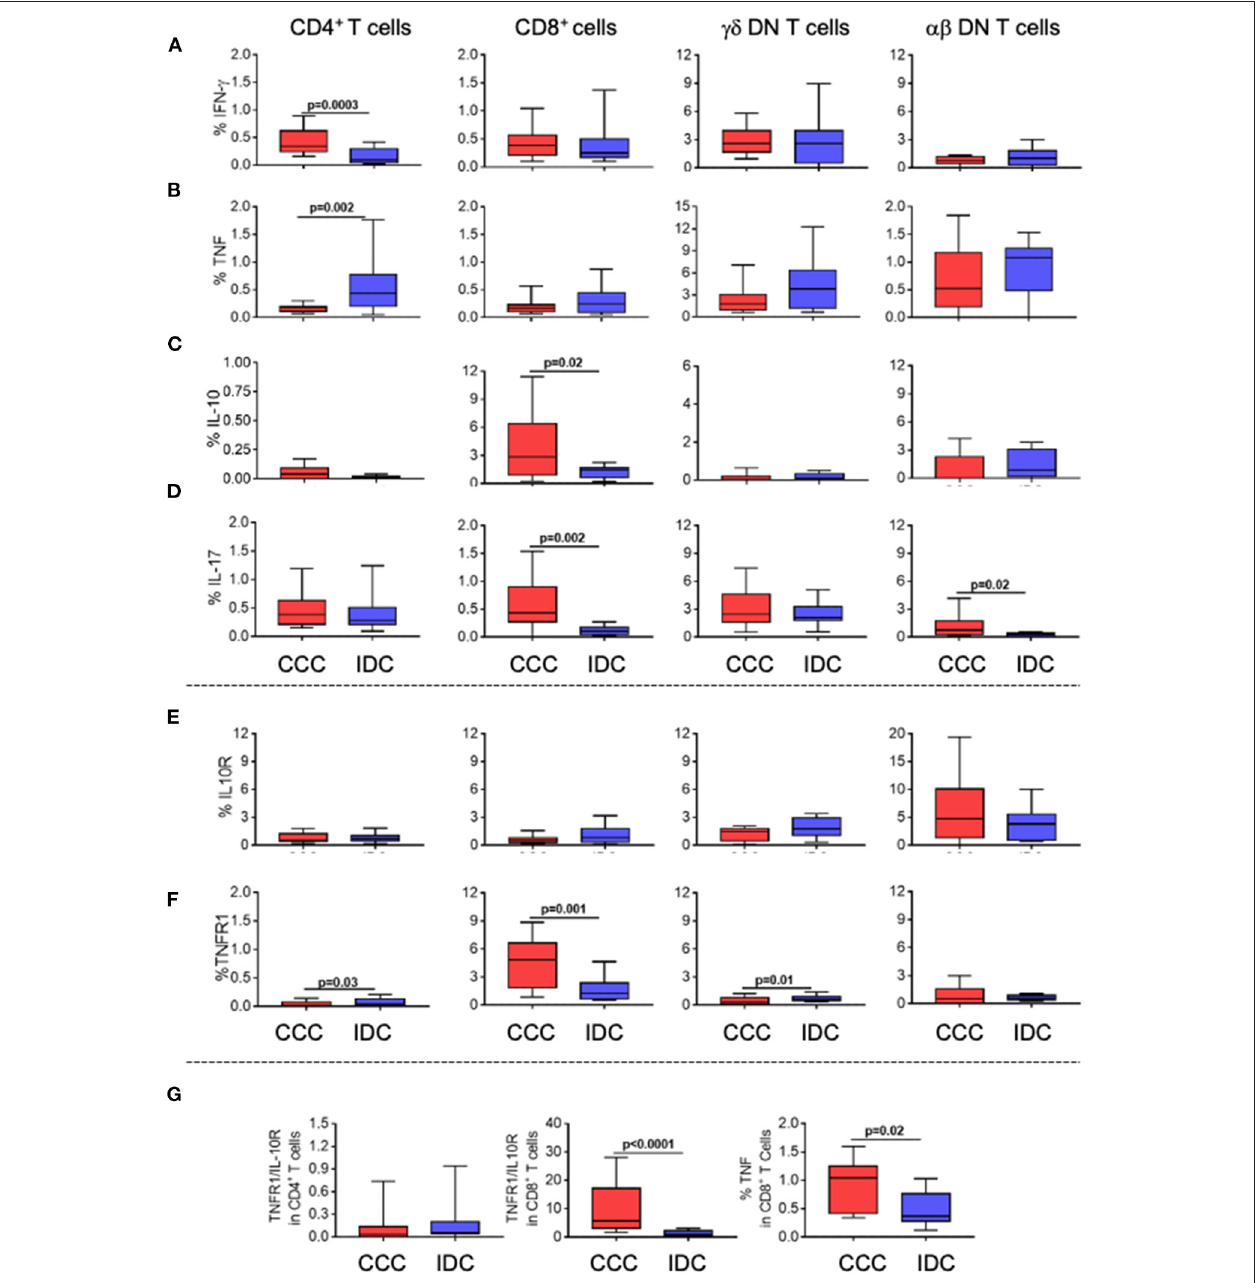
FIGURE 3 | Cellular immune profile of cytokines and immunoregulatory receptors in T-cell subpopulations in different cardiomyopathies. Frequency of expression of cytokines and immunoregulatory receptors (A) IFN-gamma, (B) TNF, (C) IL-10 (D) IL-17 (E) IL-10R, (F) TNF-R1. The analysis was performed as described in the materials and methods for comparison between the different groups in CD4 + , CD8 + , gamma-delta + (CCC, n = 17, IDC, n = 13) and alpha-beta + DN T cells (CCC, n = 10, IDC, n = 10). (G) analysis of the ratio of TNFR1 + /IL10R + cells in CD4 + and CD8 + T cells; TNF expression in CD8 + T cells stimulated with PMA/Ionomycin (CCC, n = 7; IDC, n = 8). Values of p < 0.05 were considered statistically significant. Graphs are expressed as boxplots, with the minimum and maximum values